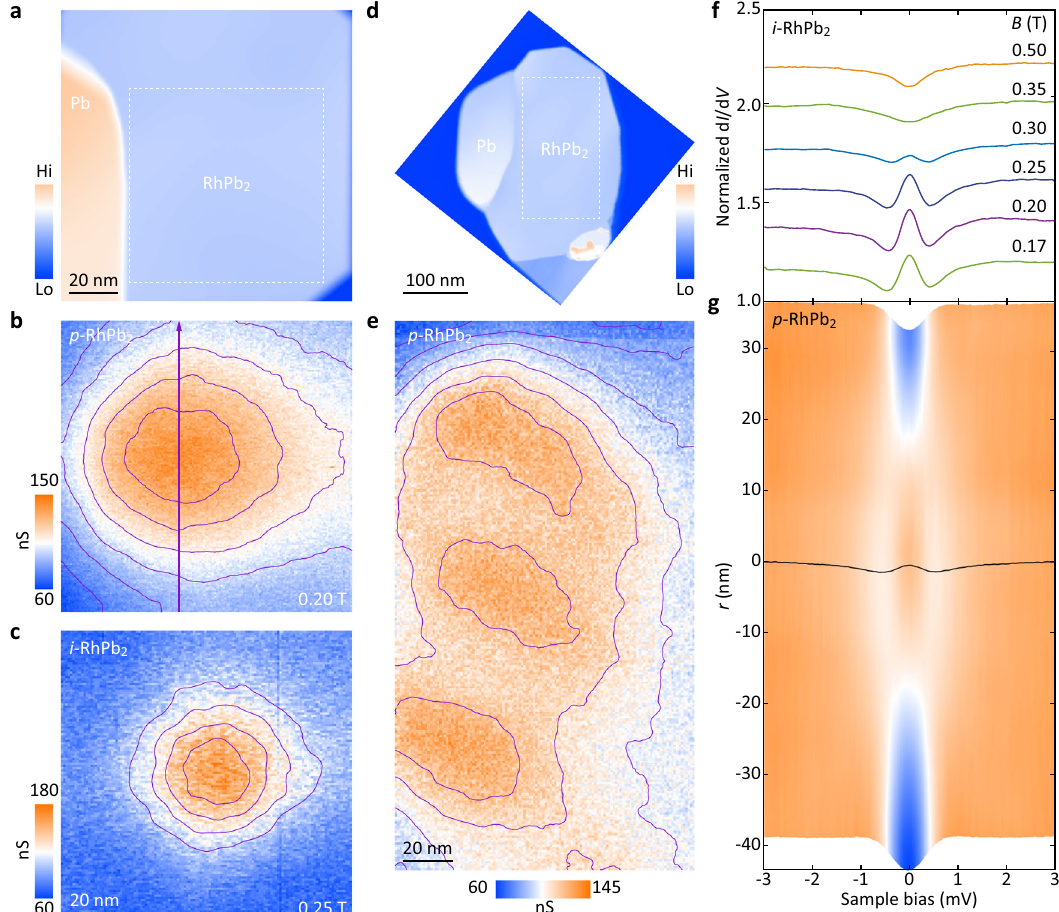
Fig. 4 Proximity vortices. a STM topography (120 nm × 120 nm, V = 4 V, I = 5 pA) of one Pb/RhPb 2 heterojunction where the proximity effect on magnetic vortices is studied. b ZBC map (80 nm × 80 nm, V = 3 mV, I = 500 pA) acquired in the square-outlined proximity region of ( a ), showing a petal-like Abrikosov vortex core at B = 0.20 T. The purple contour lines are guides for eyes throughout. c ZBC map (115 nm × 115 nm, V = 3 mV, I = 500 pA) showing a nearly circular vortex core in i -RhPb 2 ( B = 0.25 T). d STM topographic image (300 nm × 300 nm, V = 3 mV, I = 500 pA) presenting three Abrikosov vortices V = 4 V, I = 5 pA) of a larger Pb-RhPb 2 heterojunction. e ZBC map (120 nm × 220 nm, at B = 0.20 T, acquired in the rectangle-outlined proximity region of ( d ). f d I /d V spectra taken at the Abrikosov vortex center of i -RhPb 2 for various B . g Color-coded d I /d V spectra measured with varying radial distance r from the vortex center ( r = 0, the black line) along the arrowed line in ( b ). A prominent ZBCP exists at vortices and shows no splitting away from the vortex